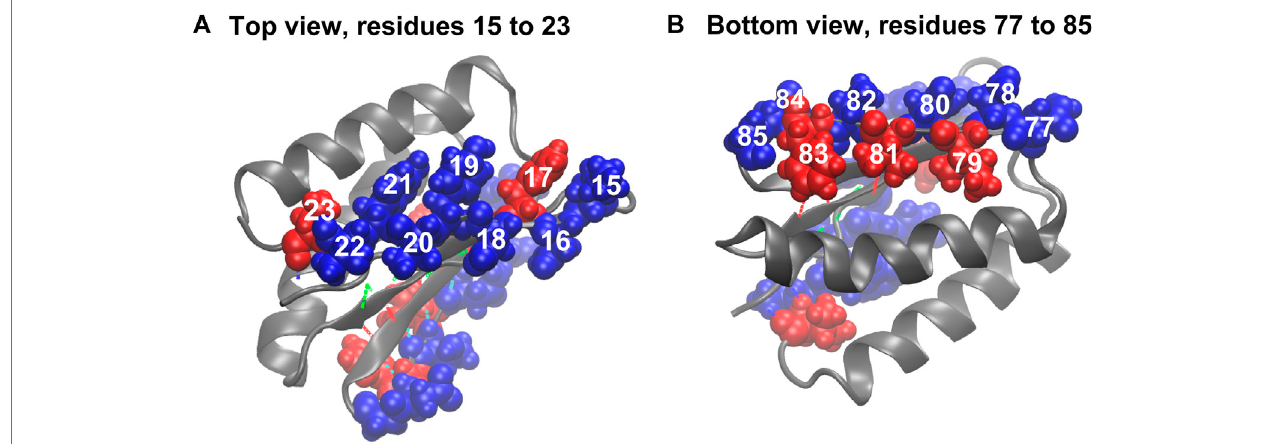
FIGURE 8 | Beta sheet bordering hydrophobic (red) and hydrophilic (blue) residues. (A) Hydrophobic and hydrophilic residues in region I. (B) Hydrophobic and hydrophilic residues in region III. For hydrogen bond coloration, see Figure 1